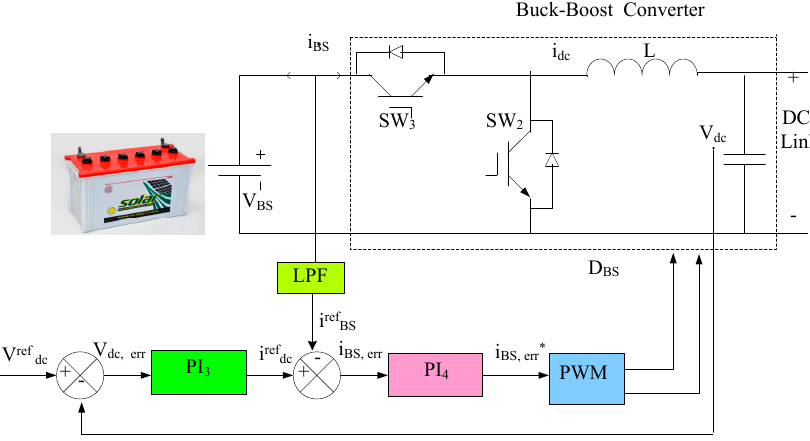
Figure 4. BS controller.